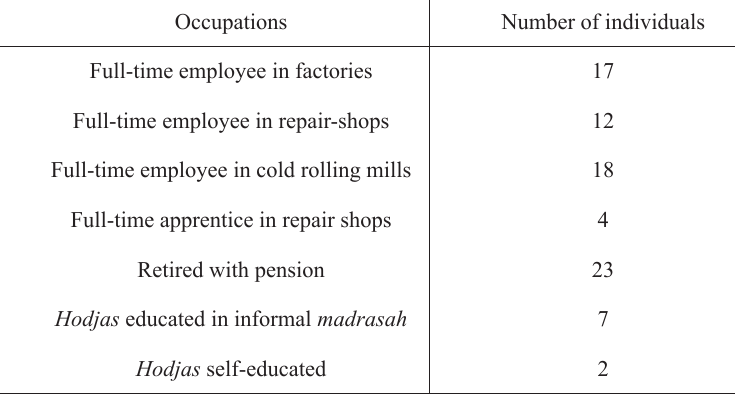
Table 2. Daytime occupations of